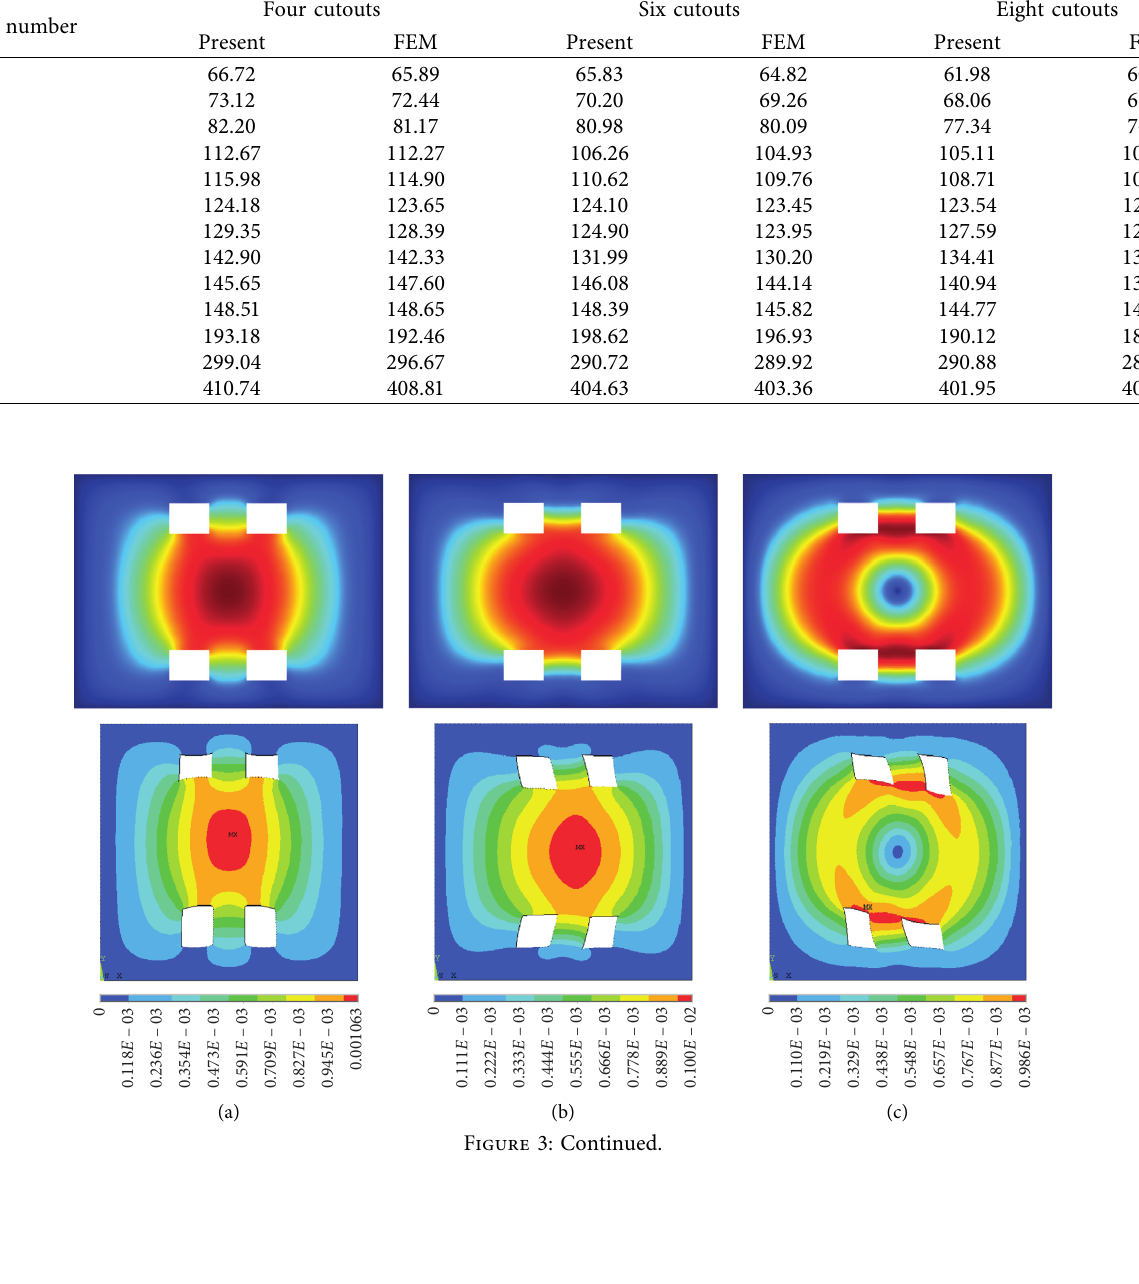
Table 2: The natural frequencies of rectangular plates with different numbers of